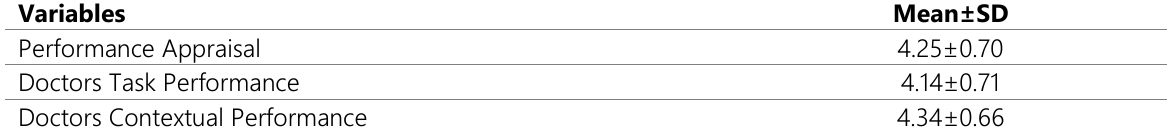
Table 1: Performance appraisal, task and contextual performance.